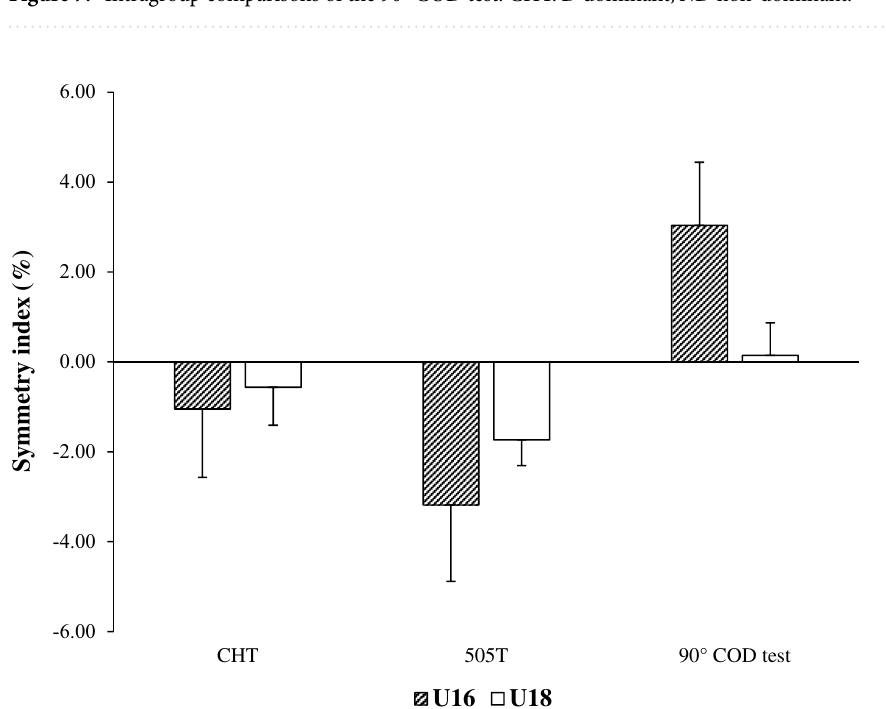
Figure 8. Intergroups comparisons of the symmetry index by age category in the change of direction tests. CHT cross-over hop test, 505 COD test and 90° COD